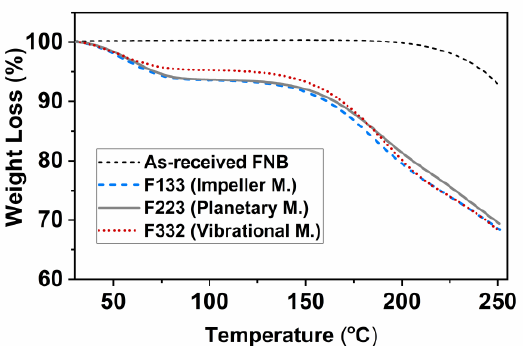
Figure 3. TGA curves of AR-FNB particles and the films containing ~23 wt% FNB concentration processed with the mixing conditions of F133, F223, F332.